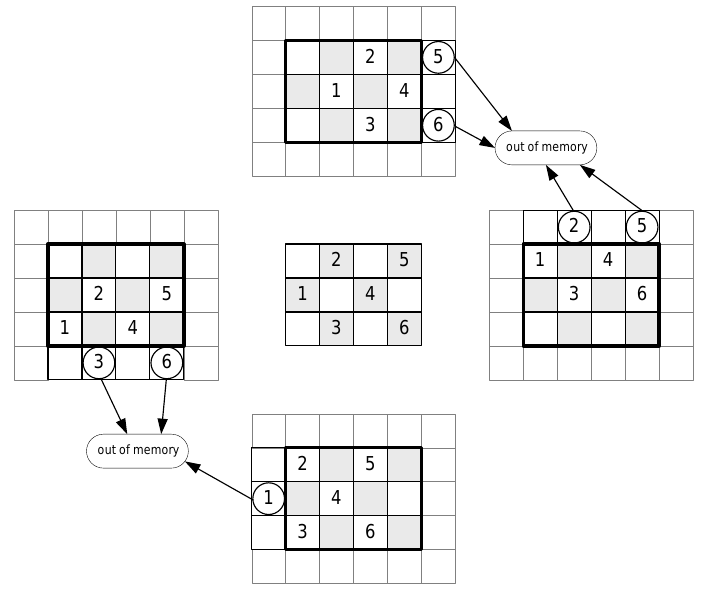
Figure 3. Memory addressing for even iterations.